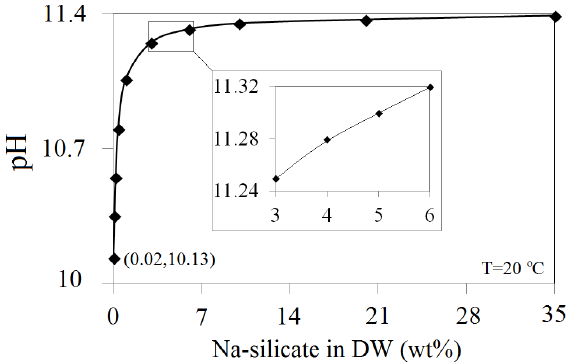
Figure 2. pH of different Na-silicate contents from 35 wt% to 0.02 wt% by dilution with distilled water (DW).